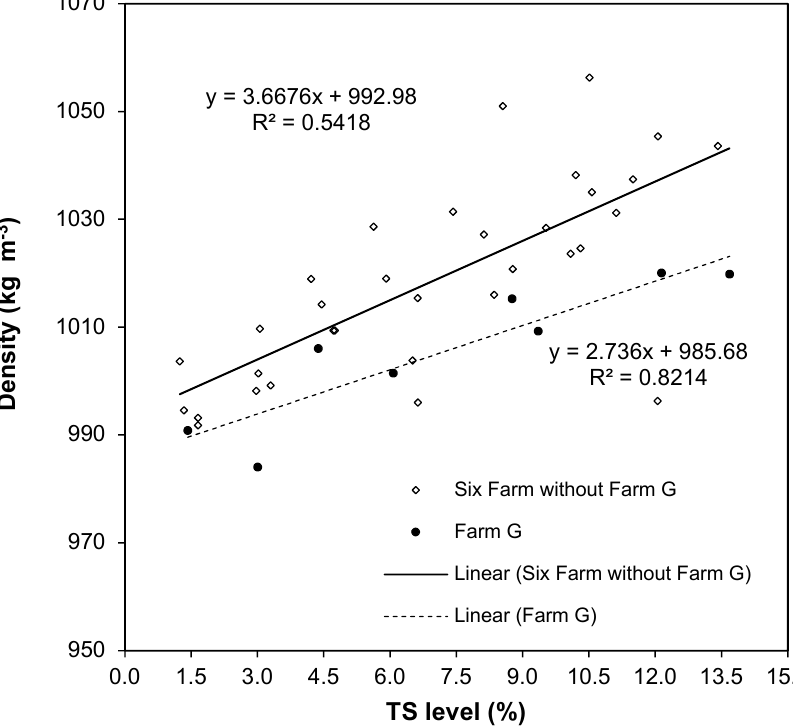
Figure 4. Density of post-digested manure as a function of total solids content.